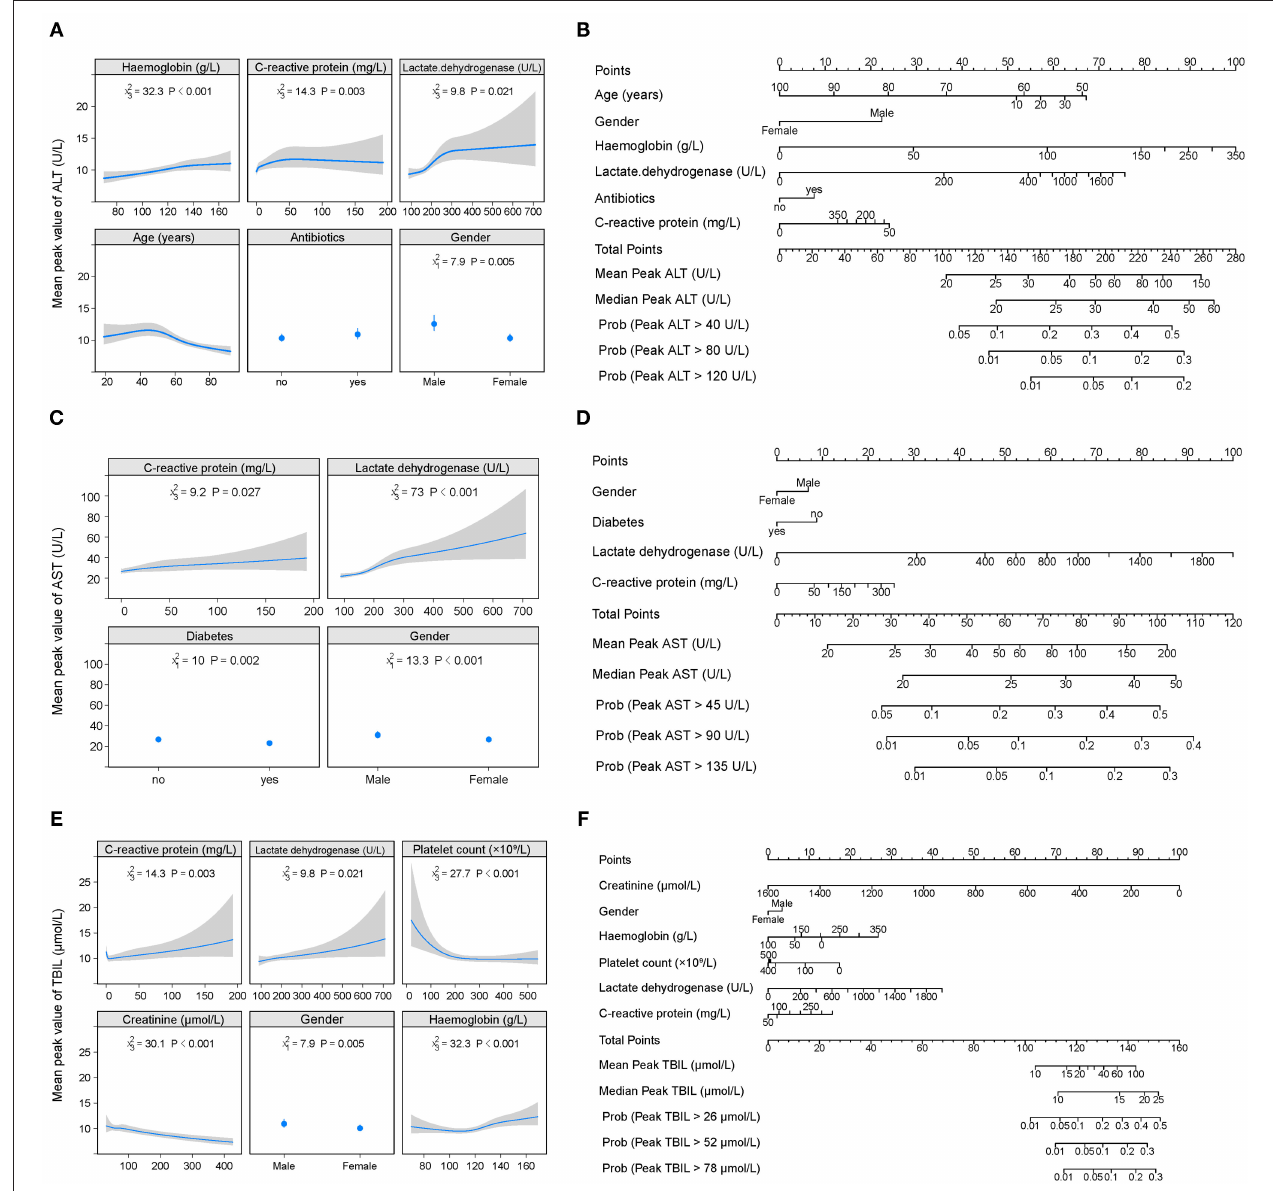
FIGURE 3 | Factors and nomogram for predicting the peak values of ALT, AST, and TBIL during hospitalization. (A, C, E) Multivariable analysis of factors associated with the peak values of ALT, AST, and TBIL during hospitalization. The non-linearity of continuous variables were considered and analyzed with restricted cubic splines. (B, D, F) Nomogram for predicting the peak values of ALT, AST, and TBIL during hospitalization. To use the nomogram, first draw a vertical line to the top points row to assign points for each variable; then, add the points from each variable together and drop a vertical line from the total points row to obtain the median, mean values of peak ALT, AST, and TBIL during hospitalization as well as the probability of above the 1-, 2-, 3-time upper limit of normal of these